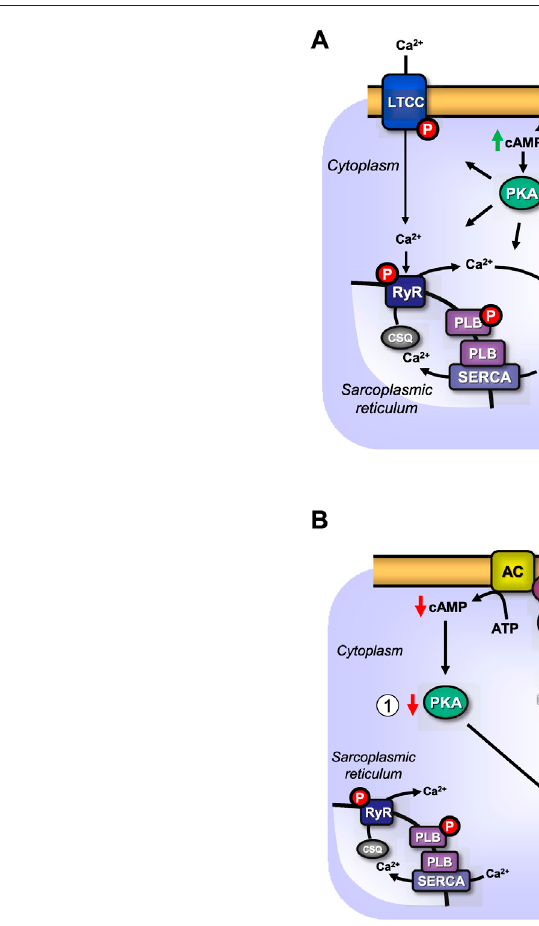
FIGURE 1 | (A) Scheme: putative mechanism(s) of signal transduction of cardiac H 2 -histamine receptors stimulated by histamine and antagonized by cimetidine. H 2 -histamine receptors(H 2 R)canactivateadenylylcyclases(AC) viastimulatoryGTPbindingproteins(G s ),whichwould enhancethe3 ′ ,5 ′ -cyclicadenosine-phosphate (cAMP)-levelsincentralcompartmentsofthecardiomyocyte.ThiscAMPcanactivatecAMP-dependentproteinkinase(PKA),whichwouldincreasethephosphorylation state and thereby, the activity of several regulatory proteins in the cardiomyocyte. For instance, PKA-stimulated phosphorylation increases the current through the L-type Ca 2+ channel (LTCC) and/or the release of Ca 2+ from the sarcoplasmic reticulum (SR) via the cardiac ryanodine receptor (RYR). This process isthought to initiate cardiac contraction. In diastole, Ca 2+ is pumped via the SR-Ca 2+ -ATPase (SERCA) from the cytosol into the SR. Activity of SERCA is increased when PKA phosphorylates phospholamban (PLB). PKA also phosphorylates the inhibitory subunit of troponin (TnI). The phosphorylation of TnI reduces the sensitivity of the myo fi laments for Ca 2+ and thus the muscle will relax faster in diastole. The latter effect might also follow from inhibition of PP2A (a serine/threonine phosphatase: PP) activitybyMAPkinases(mitogenactivatedproteinkinases)andsubsequentincreasedphosphorylationstateandthusactivationofI-1(aspeci fi cinhibitoryproteinofPP1 [serinethreonineprotein phosphatase 1]),whichwillleadtodecreasedactivityofPP1.PKAcanalsophosphorylateandthusactivatethecAMP-dependenttranscription factor (CREB). Alternatively (sometimes called the non-canonical pathway) the phosphorylation state and thus the activity of ERK1/2, JNK (c-jun N terminal kinase), p38 (p38 mitogen activated protein kinase) could be enhanced by pathways acting via arrestins. In the human heart, via H 2 -histamine receptor, cAMP-content is increased, PKA is activated, phospholamban and troponin I phosphorylation is enhanced and the open probability of the LTCC is augmented. (B) Scheme: putative mechanism(s) of signal transduction of cardiac H 1 -histamine-receptors, stimulated after endogenous agonist binding (histamine) on the receptor which can be abrogated by an exogenous antagonist like mepyramine. Three putative pathways are indicated with Arabic numbers. H 1 -histamine receptors (H 1 R) via (labeled 1 in the scheme) the α -subunitsoftheinhibitoryGTP-bindingproteins(Gi α )caninhibittheactivityofadenylylcyclases(AC)whichwouldreducethe3 ′ -5 ′ cyclicadenosine-phosphate(cAMP)- levels in central compartments of the cardiomyocyte and thus diminish the activity of cAMP-dependent protein kinases (PKA), which eventually leads to a decline in the phosphorylation state of regulatory proteins in the cell. Alternatively (labeled 2 in the scheme) the activity of phospholipase A2 (PLA 2 ) might be increased leading to formationofarachidonicacid(AA)and fi nallyactivationofproteinkinaseC(PKC)leadingtoproteinphosphorylationandhenceincreasedforcegeneration.Lastly(labeled 3 in the scheme), H 1 -histamine-receptors may via GTP binding proteins called G q or G 11 activate phospholipase C (PLC). This would increase the level of diacylglycerol ( (cid:1) DAG) in the cells and thus elevate the activity of PKC. In addition, PLC leads to the formation of inositol trisphosphate (IP 3 ), which can release Ca 2+ from storage sites like the sarcoplasmic reticulum (SR), where it binds to calsequestrin (CSQ) is taken up by SR-Ca 2+ ATPAse (SERCA) which is activated when phospholamban (PLB) is phosphorylatedbyPKA orCaMKII. Ryanodine receptor upon theirphosphorylationreleaseCa 2+ fromtheSRwhich thencontributes toforce generation.Anelevation of cytosolic Ca 2+ is expected to bind to calmodulin and this can activate a kinase (CaMKII). This kinase can phosphorylate and activate nitric oxide (NO) synthase (NOS). This activation would lead to the enhanced formation of NO which stimulates guanylyl cyclase (GC) thus increases 3 ′ -5 ′ cyclic guanosine-phosphate (cGMP) levels. Elevated cGMP can reduce the activity of phosphodiesterase III (PDE III) or enhance the activity of phosphodiesterase II (PDE II). This would elevate or reduce cAMP, respectively, which would activate or inhibit PKA and eventually increase or decrease force generation. In the human heart, H 1 -histamine receptor stimulation increases cGMP-andcAMP-levels,activatePKAandincreaseforceofcontraction(Sandersetal.,1996).Incontrast,othersreportedadecreaseofforce,atleastinsomepatients after H 1 -histamine receptor stimulation (Guo et al., 1984; Du et al., 1993).